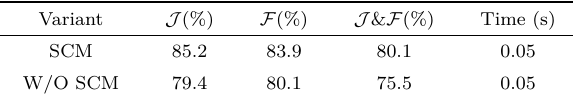
Table 3 Memory usage for our framework and STM, at various numbers of video frames n